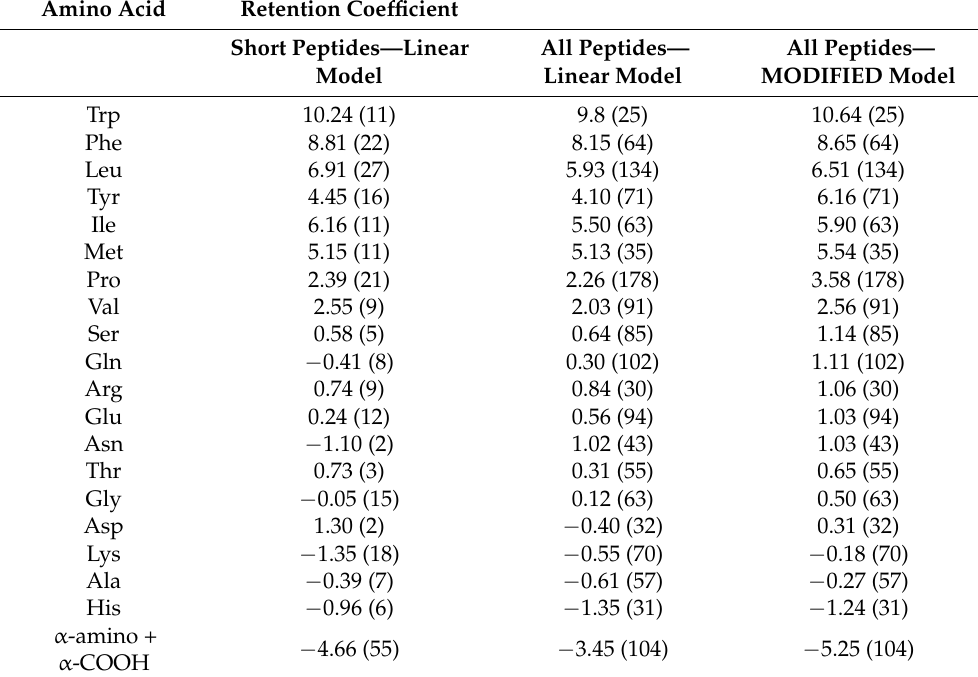
Table 4. Retention time coefficients for amino acids and termini using linear and modified models [23]. Amino Acid Retention Coefficient Short